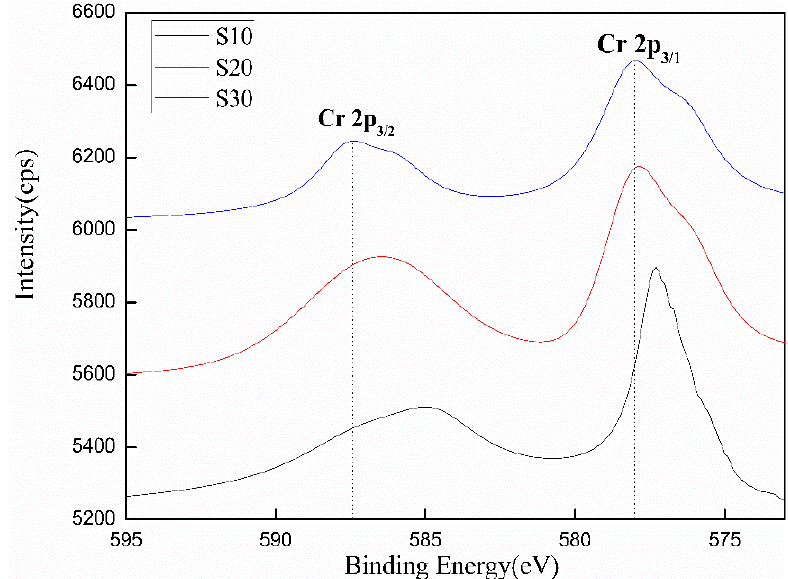
Figure 5. XPS patterns of Cr in different samples (S10, S20,